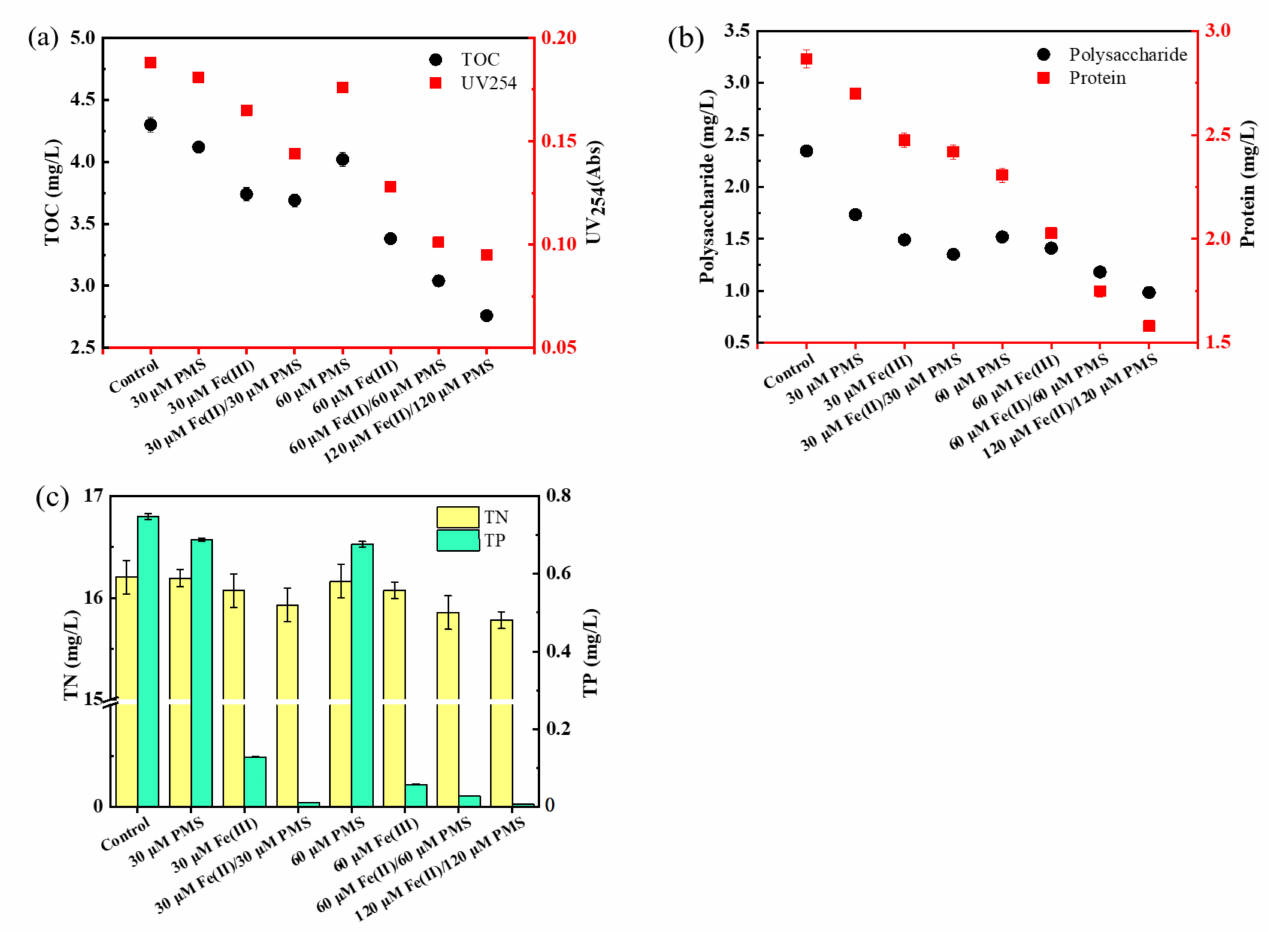
Figure 3. Pollutants in the permeate water of UF under different conditions: ( a ) concentrations of TOC and UV 254 ; ( b ) concentrations of polysaccharide and protein; ( c ) concentrations of TN and